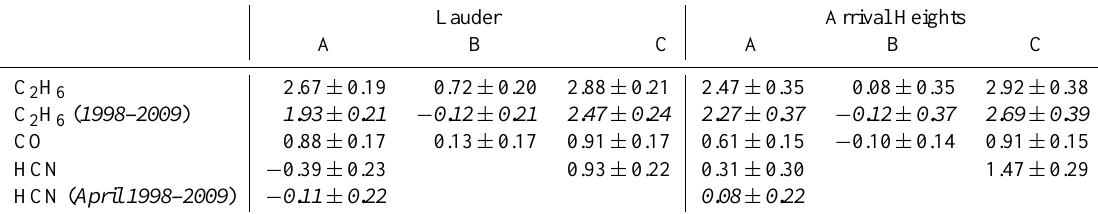
Table 3. Trends of the residuals and 2 σ uncertainties from the run with interannually varying biomass burning emissions and non-varying industrial emissions (A), the run with interannually varying biomass burning emissions and decling anthropogenic emissions of C 2 H 6 and CO (B), and the run with annually periodic biomass burning and anthropogenic emissions (C) over the period of 1997–2009: modelled- observed. Units are in %yr − 1 relative to the mean partial columns of the observed FTIR data. Values in italics denote trends calculated from 1998.